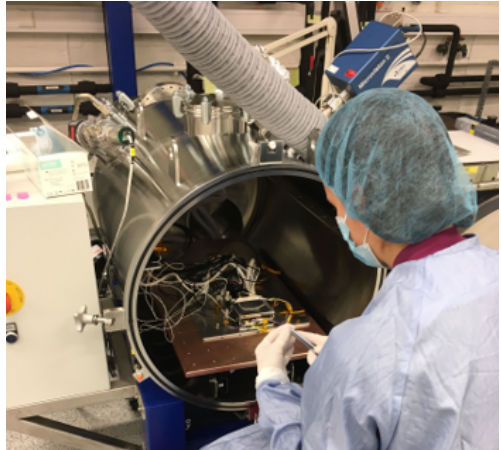
Figure 15. Payload QM and temperature sensors mounted in the TVAC